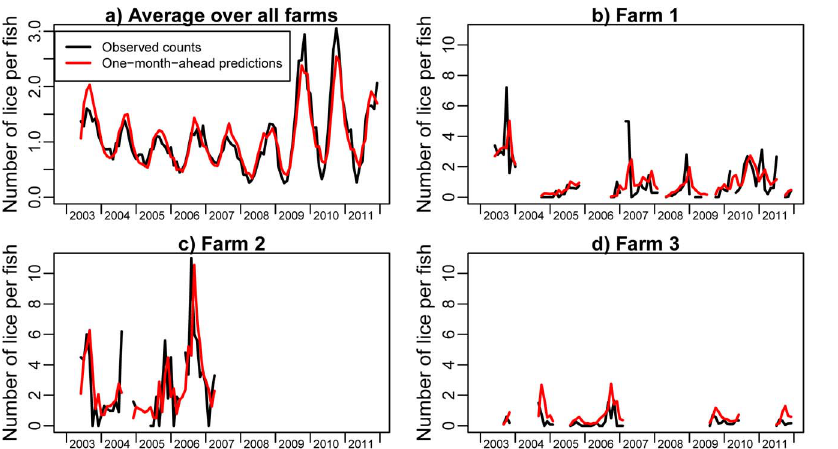
Figure 1. Time plots of observed (black) and one-month-ahead predictions (red) of salmon lice abundance averaged over all farms (panel a), and for three selected farms (panels b, c and d).